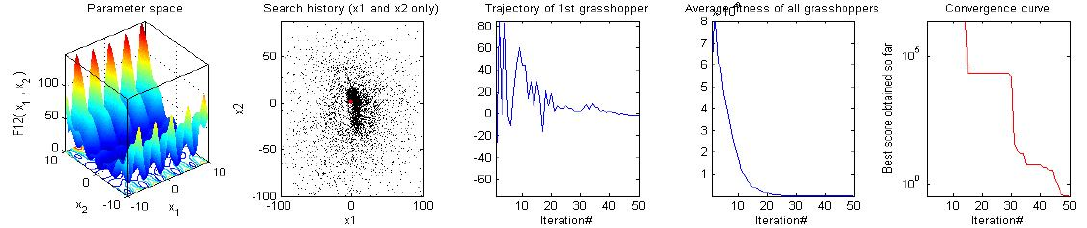
Figure 13. HAGOA behavior on multimodal function (F12)